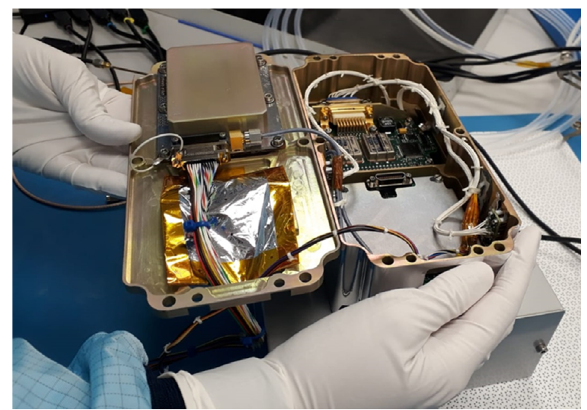
Fig. 14. Photograph showing one of the IRIS fl ight units, complete with integrated INMS, TOPCAT II, and RadMon, whilst at SSTL. The pass-thru to the bus avionics section is temporarily covered by multi-layer insulation